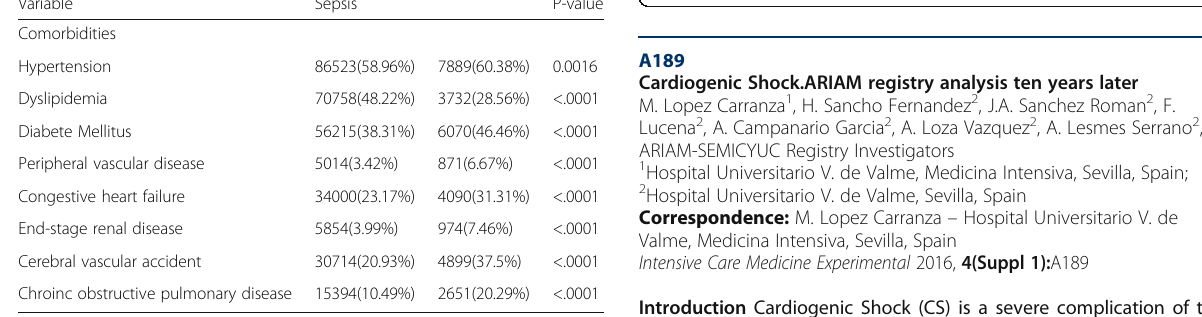
Fig. 83 (abstract A188). Kaplan-Meier survival curve after